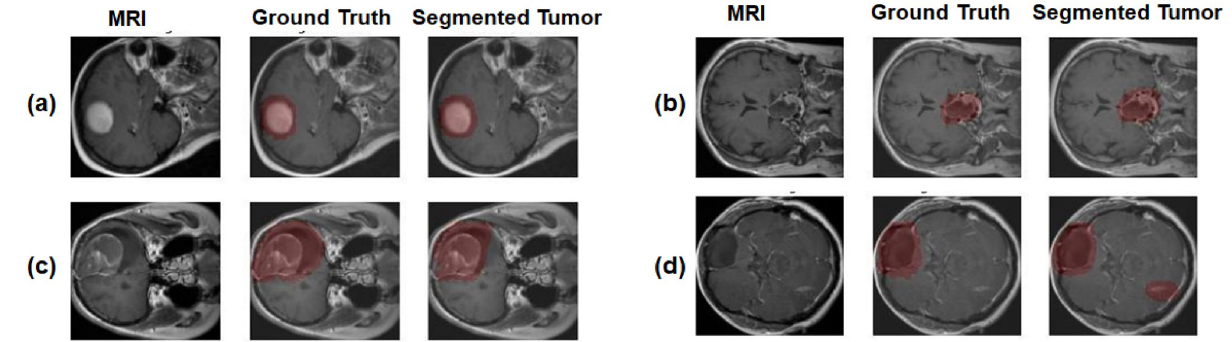
Fig 26. Sample segmentation outputs for 2D U-Net